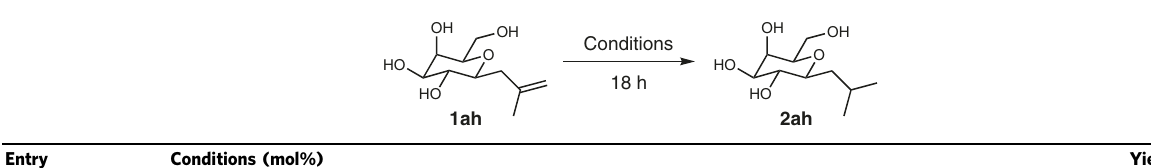
Table 3 Comparison of the HAT hydrogenation performance for the preparation of IBCG 2ah.